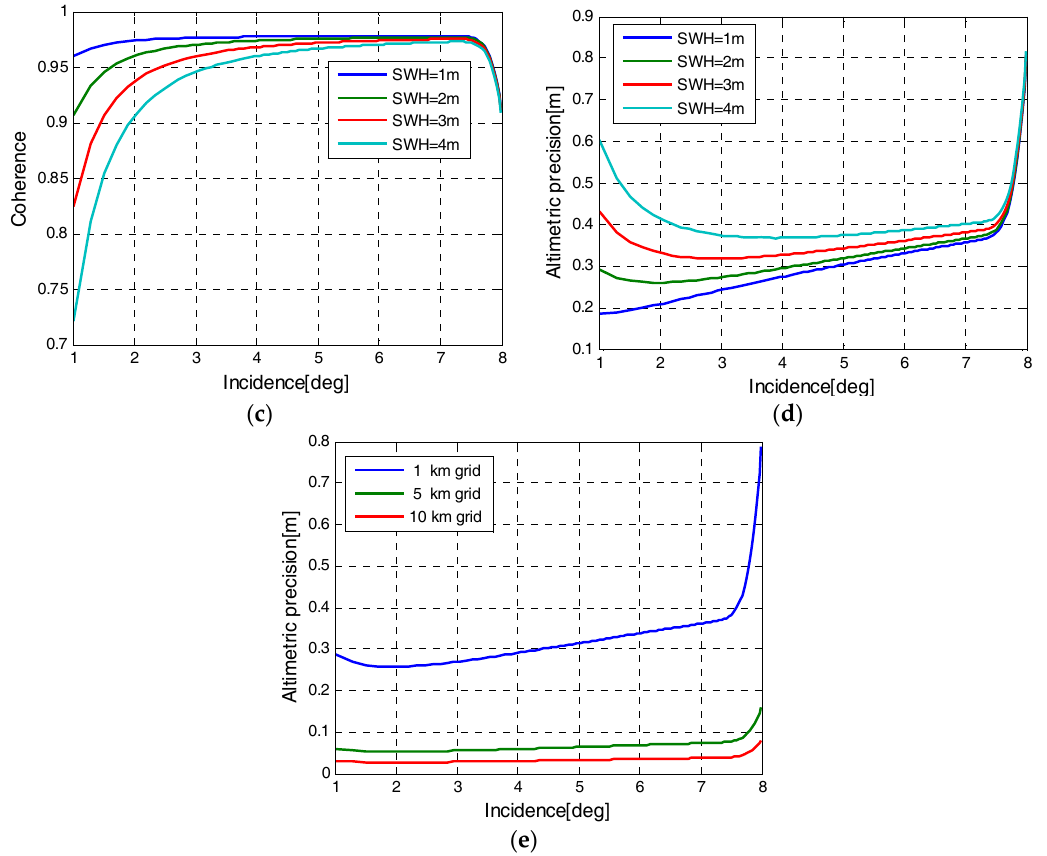
Figure 5. ( a ) Signal ‐ to ‐ noise ratio (SNR) curve estimated from InIRA acquired data; ( b ) volumetric decorrelation coefficient; ( c ) coherence, and; ( d ) altimetric precision under a different significant wave height (SWH) setting; ( e ) altimetric precision on a different resolution grid, the SWH is set to be 2 m during the simulation.